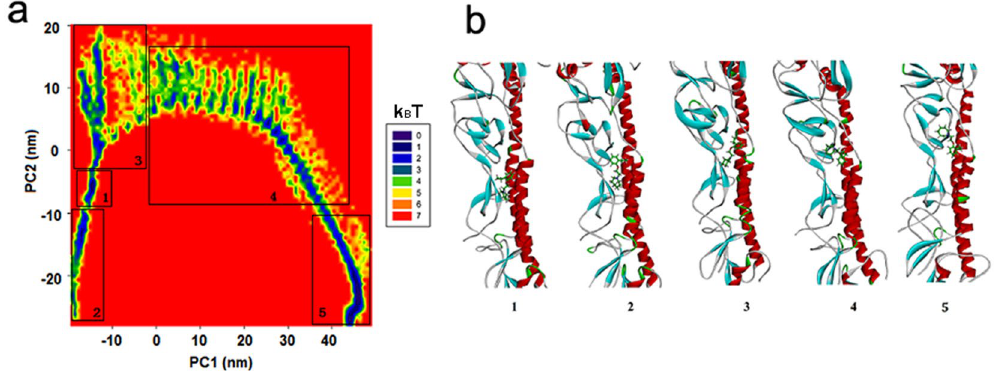
Figure 8. ( a ) Relative free energy surfaces along the first two principle components (PC-1, PC-2) of INT-HA 1ruz under acidic conditions. ( b ) Five representative conformations extracted from different